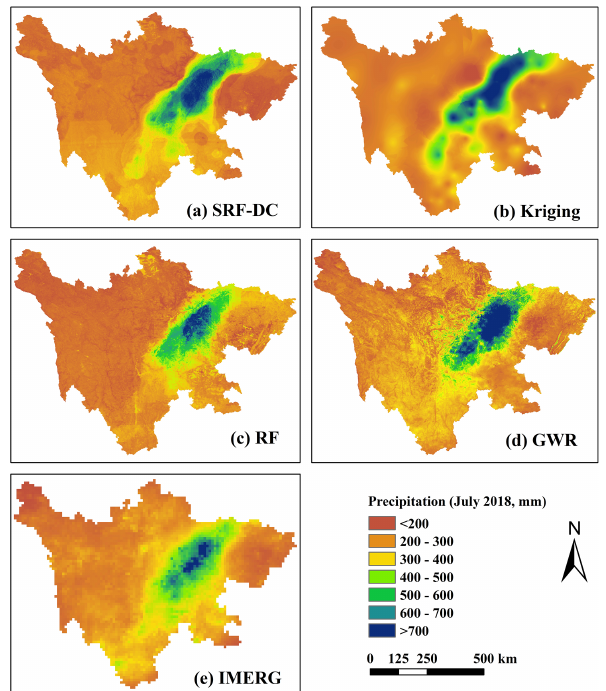
Figure 8. Downscaled and calibrated precipitation maps of SRF- DC and some representative methods in the wettest month (July